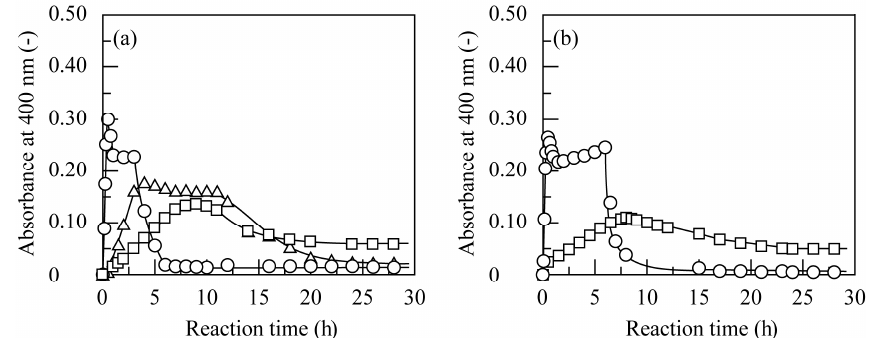
for 4TBP, 2.0 U/cm 3 for 4NPenP, and 30 U/cm 3 for 4TPenP at pH 6.0 and 40 °C.